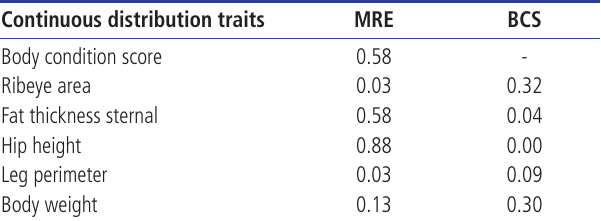
Table 4. Genetic correlations of categorical traits of marbling ribeye (MRE) and body condition score (BCS) with ribeye area, fat thickness sternal, hip height, leg perimeter, and body